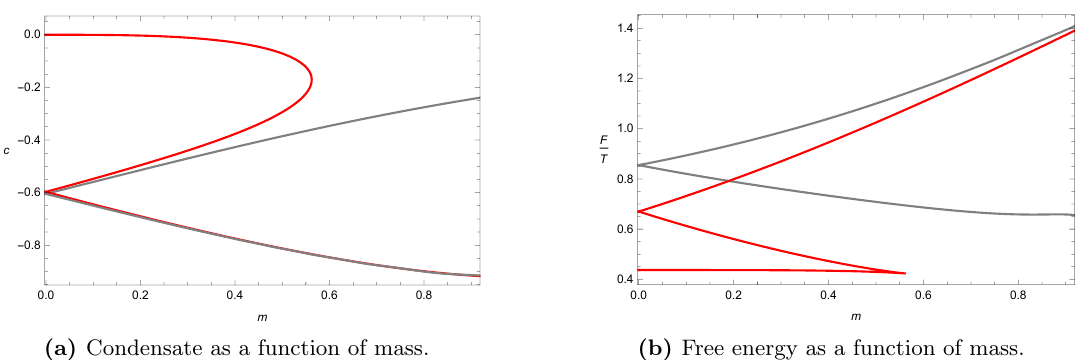
Figure 2. The SU(2) R triplet condensate and free energy as a function of triplet mass in the topo- logical (black) and gapless (red) phases respectively. The gapless phase dominates the topological one whenever it exists. We work in units where the parameter r 0 appearing in (2.2) is unity. simply the area of the D5 brane. The corresponding Lagrangian density